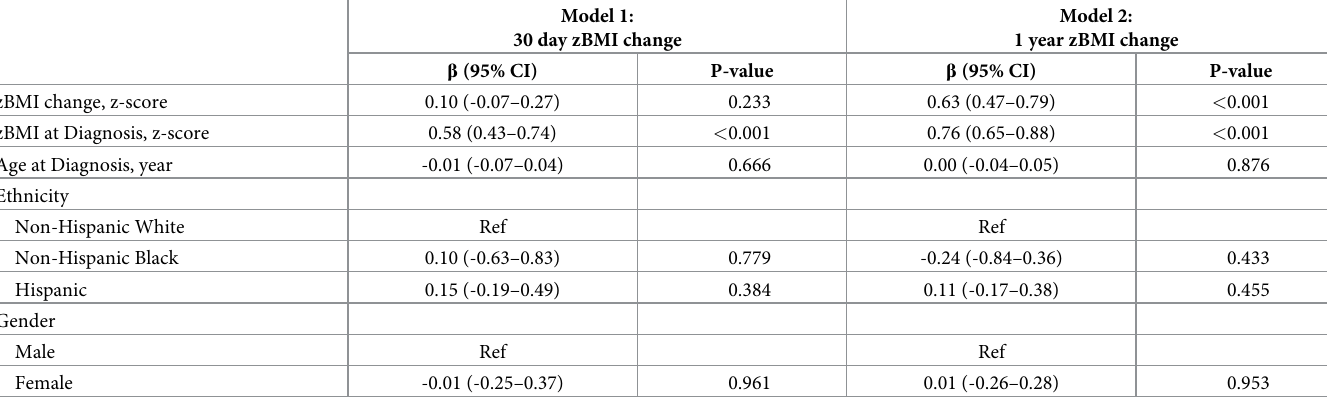
Table 2. Association between clinical and demographic factors and BMI z-score at 5 years post-diagnosis among pediatric ALL